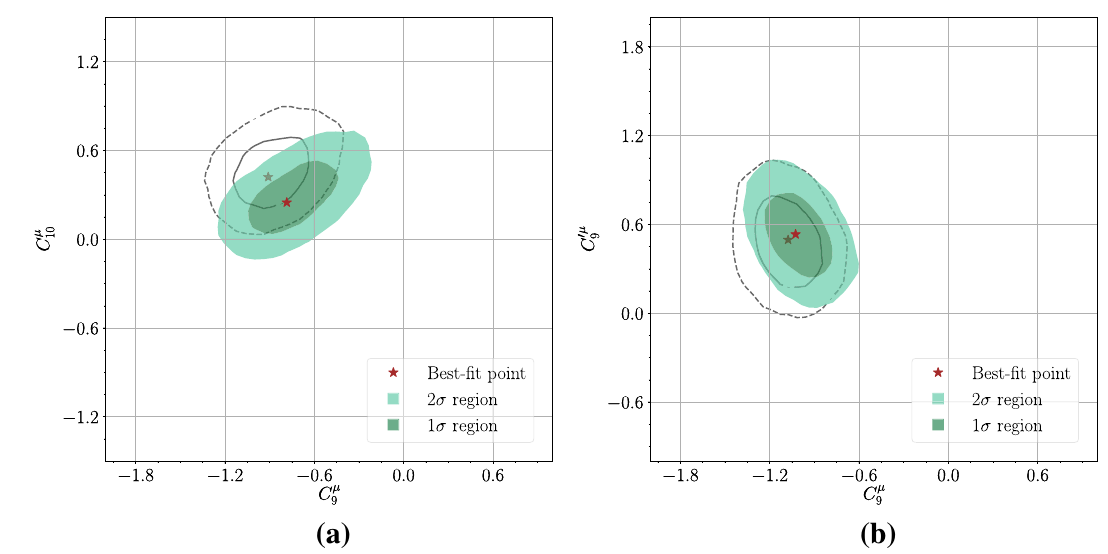
1 σ ( 2 σ) credible region of the pdf corresponding to the data pre-LHCb μ μ Run 2. The associated best-fit point is also shown in gray. b Same as a , C (third row of 9 10 for the scan parametrized by C